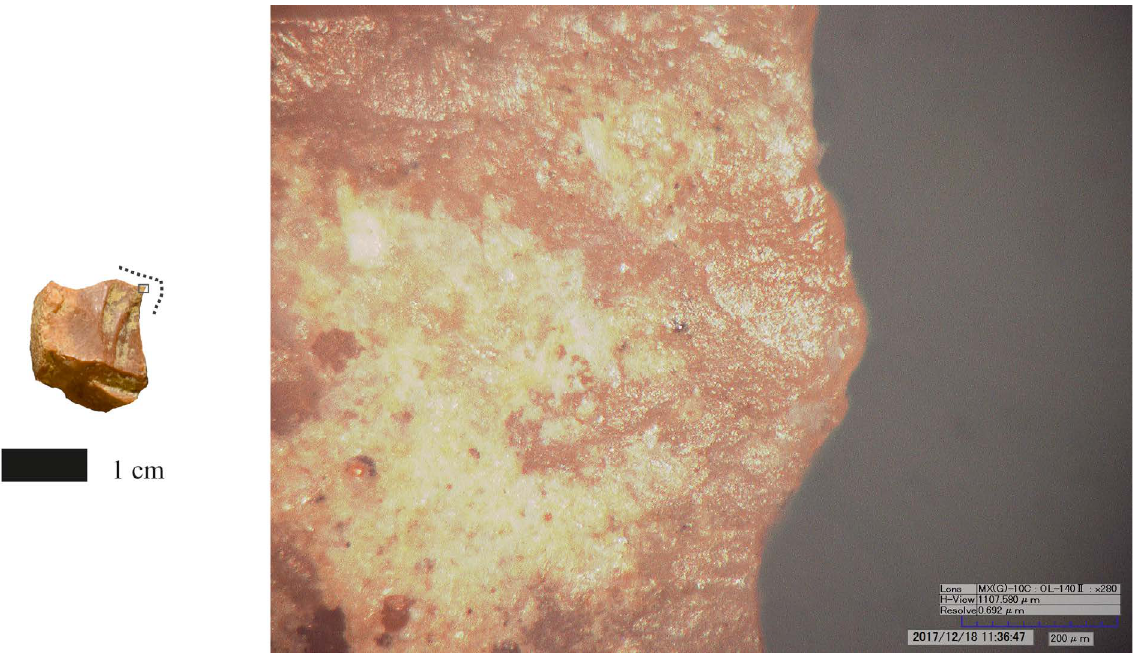
Figure 17. Use-wear polish associated with edge rounding of the small flake ID 882 (the scale bar is 200